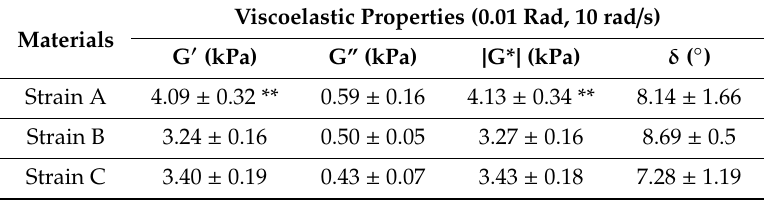
Table 1. The viscoelastic parameters of the model hydrogels fabricated from di ff erent strains of SF measured at 0.01 rad and 10 rad / s ( n = 3). The parameters of strain A such as G (cid:48) and | G* | , complex shear modulus, were significantly higher than strain B and C.